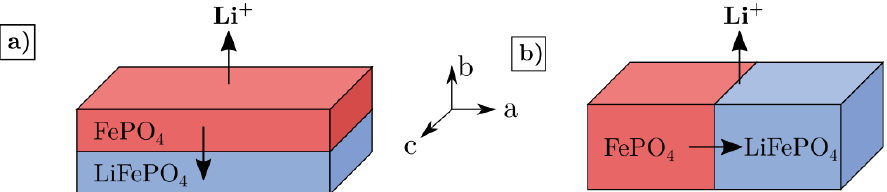
Figure 15. Scheme of the phase boundary movement for LFP. ( a ) Phase boundary moving along the b -axis; ( b ) Phase boundary moving along the a